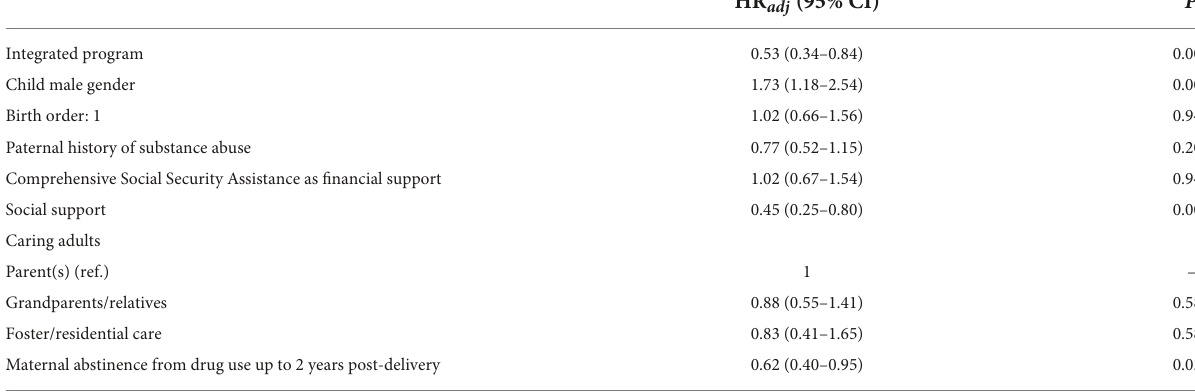
TABLE 3B Factor associated with any developmental delay: Cox regression multivariable